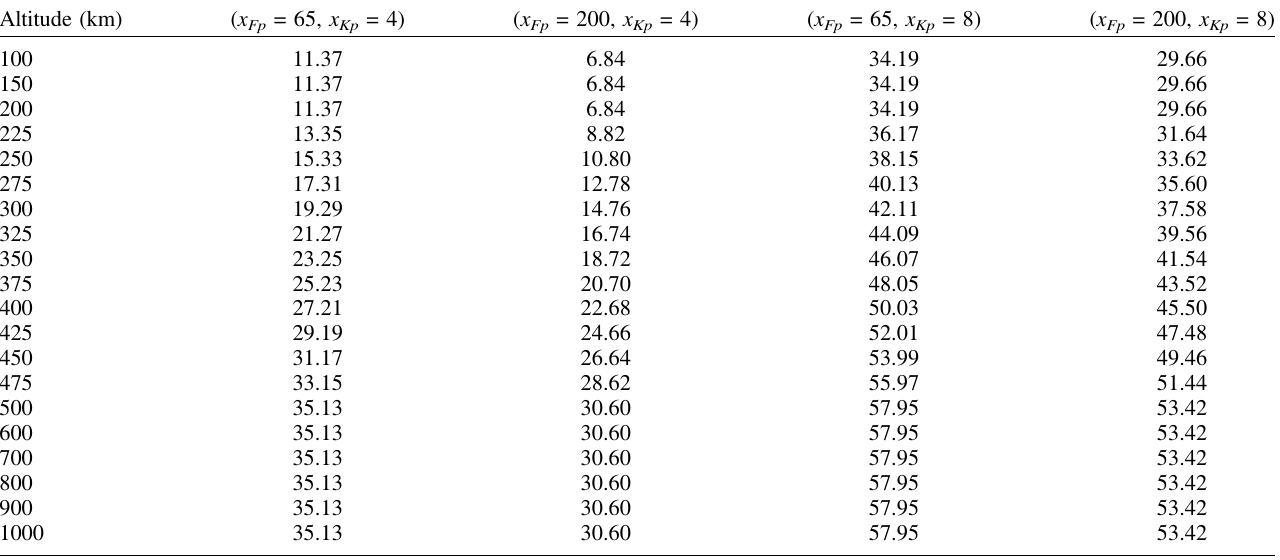
Table 2. One-sigma uncertainty as a function of altitude for different solar fl ux values and magnetic index K p values. Altitude (km)